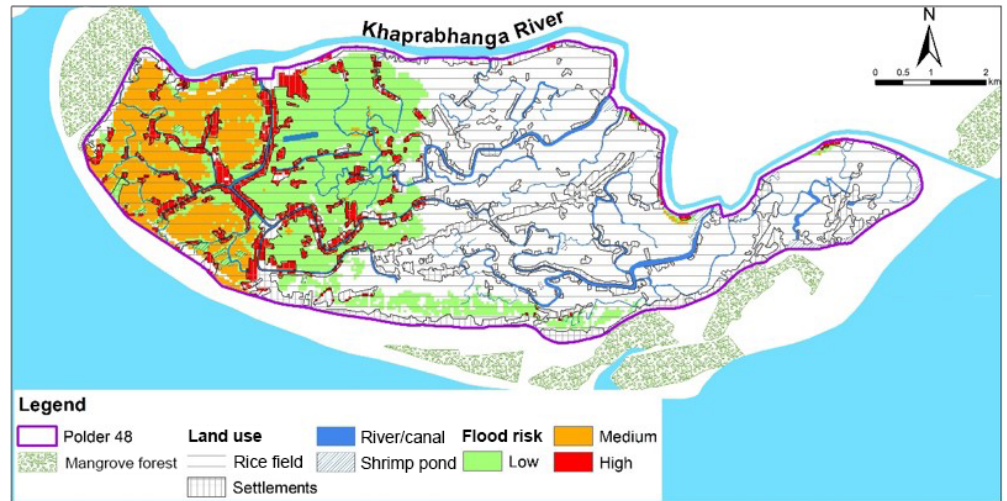
Figure 12. Flood risk map corresponding to the breaching at the critical location of the dike. The following three classes of risk are shown: high, medium and low. The four land uses considered are shown as well.